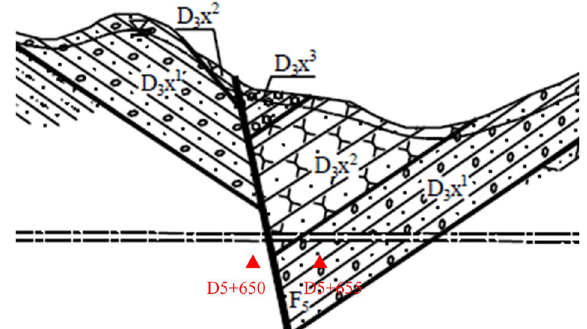
Figure 11. Geological distribution of the sampling site.